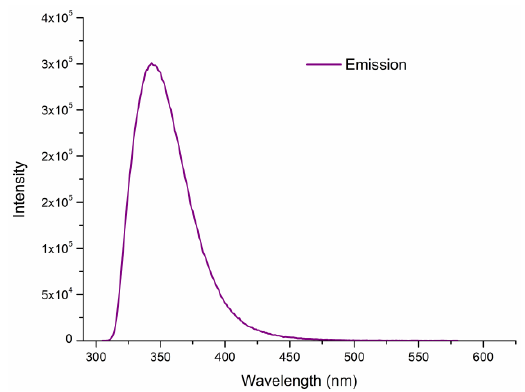
Figure 11. The emission (solid) spectra of the sesamol (λ ex = 294 nm).